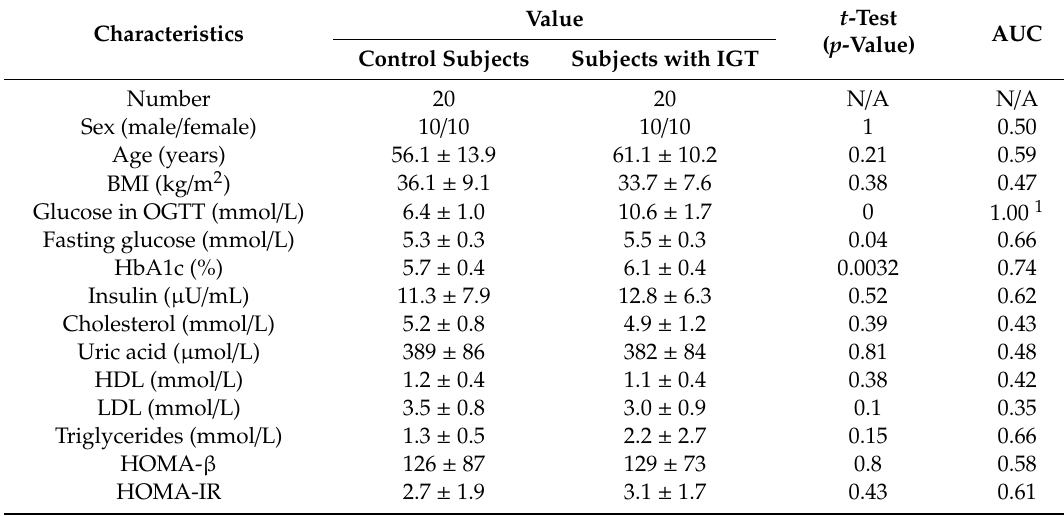
Table 1. Clinical characteristics of the patient